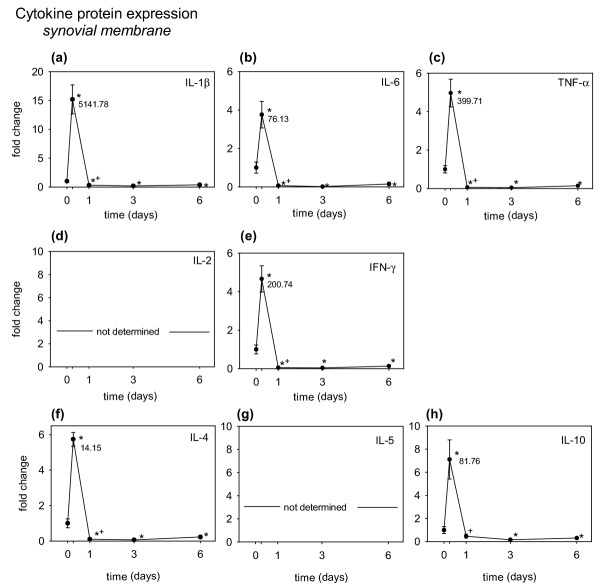
Expression of proteins for various cytokines in the synovial membrane of rats with AIA. Expression of protein was assessed before the induction of antigen-induced arthritis (AIA) (day 0) or afterwards (at 6 hours and on days 1, 3, and 6). Data were originally expressed as ng/mg total protein and then related to values of day 0 (fold change; peak values in ng/mg total protein are indicated for 6 hours). Values are means; vertical bars indicate the standard error of the mean (n = 5 to 6 rats for each time point). *P ≤ 0.05 in comparison with day 0; +P ≤ in comparison with the preceding date.